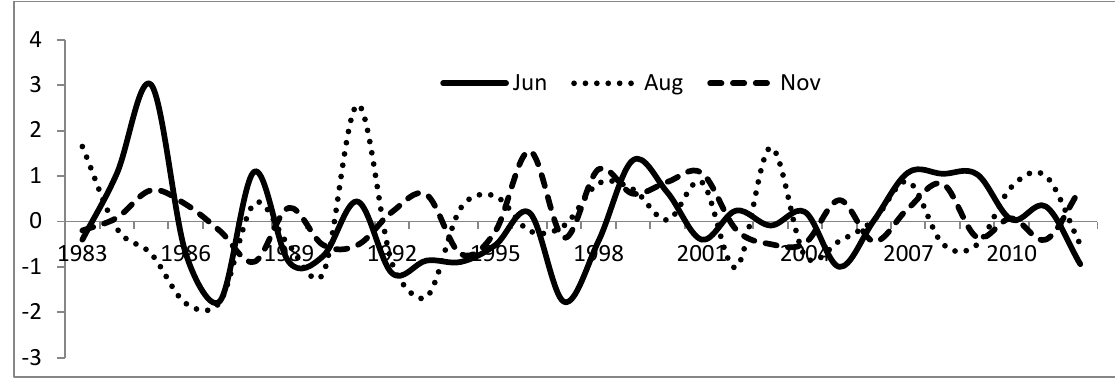
Figure 4. Aggregated two-month SPI values based on June, August, and November for Kampong Speu station, 1983–2012.